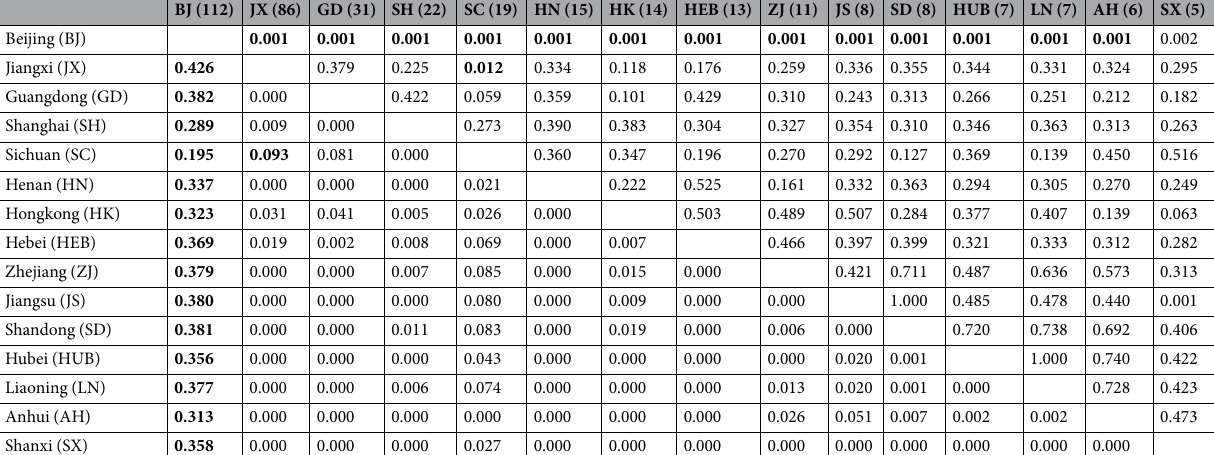
Table 4. Evidence for genetic differentiation among geographic populations of C. neoformans in China. The pairwise population F ST values are shown below diagonal. The probability of the observed F ST values being statistically significant is shown above diagonal, with a P value of < 0.05 rejecting the null hypothesis that the two compared populations are genetically similar to each other. The abbreviations on the top row are the same as those in the left column. Numbers in parenthesis of the top row are the numbers of isolates from each of the geographic